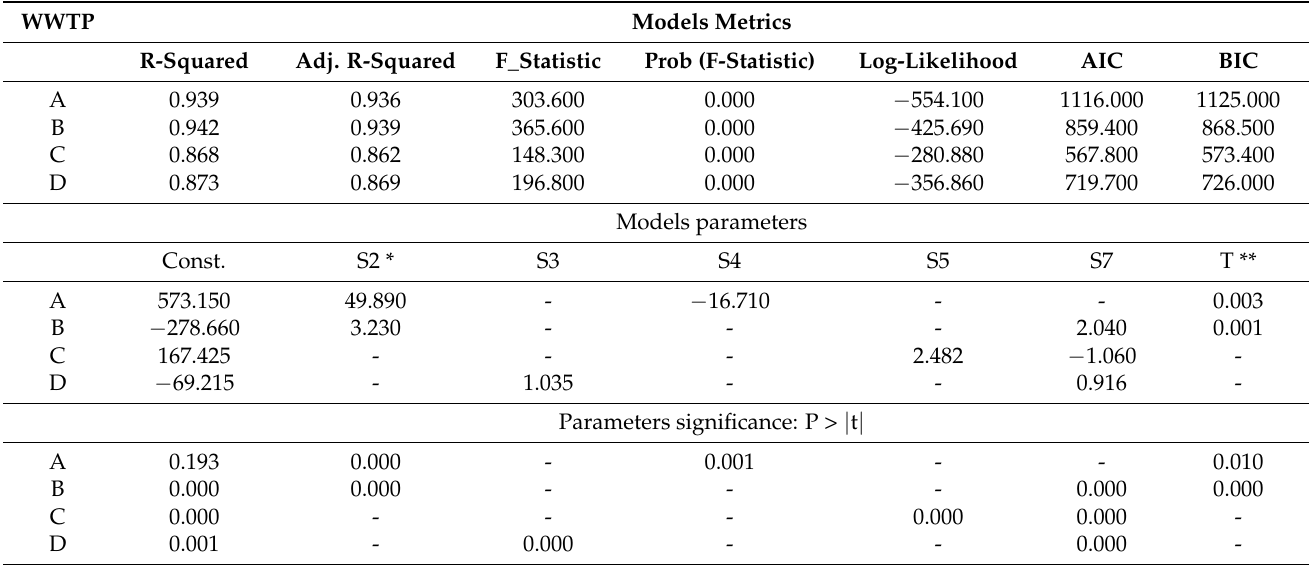
Table 3. Results of ANOVA for best linear model structures for WWTPs A–D.